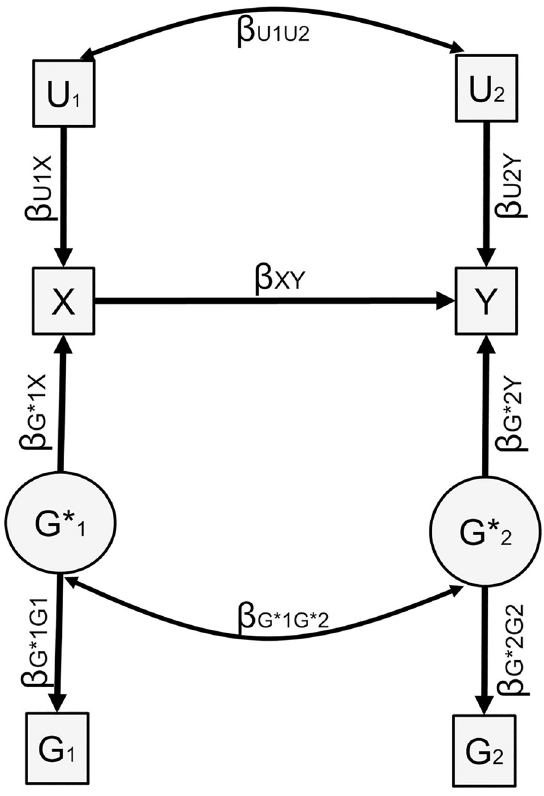
Fig 8. Simulation generative model. The figure represents the generative model for